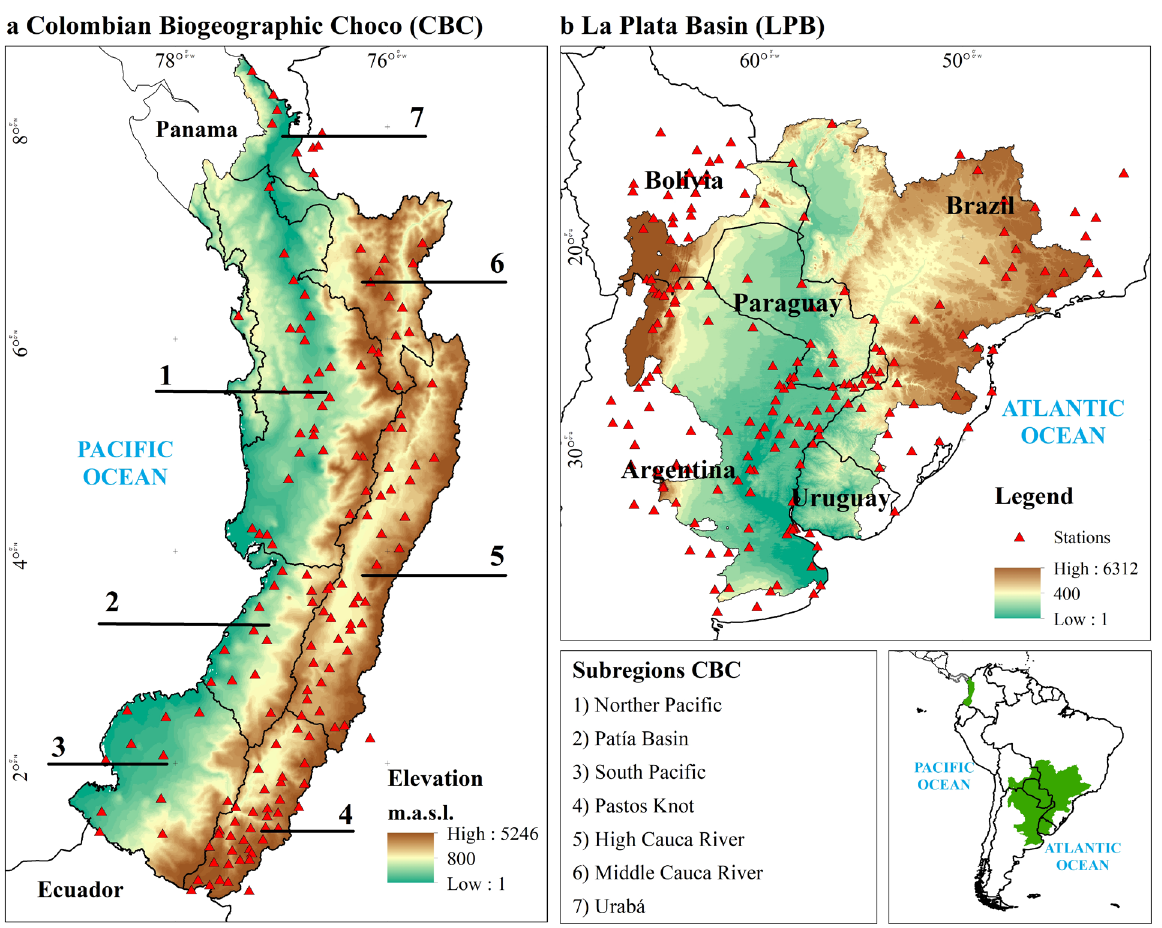
Figure 1. Raingauge stations for: a) Colombian Biogeographic Choco (CBC), and b) La Plata